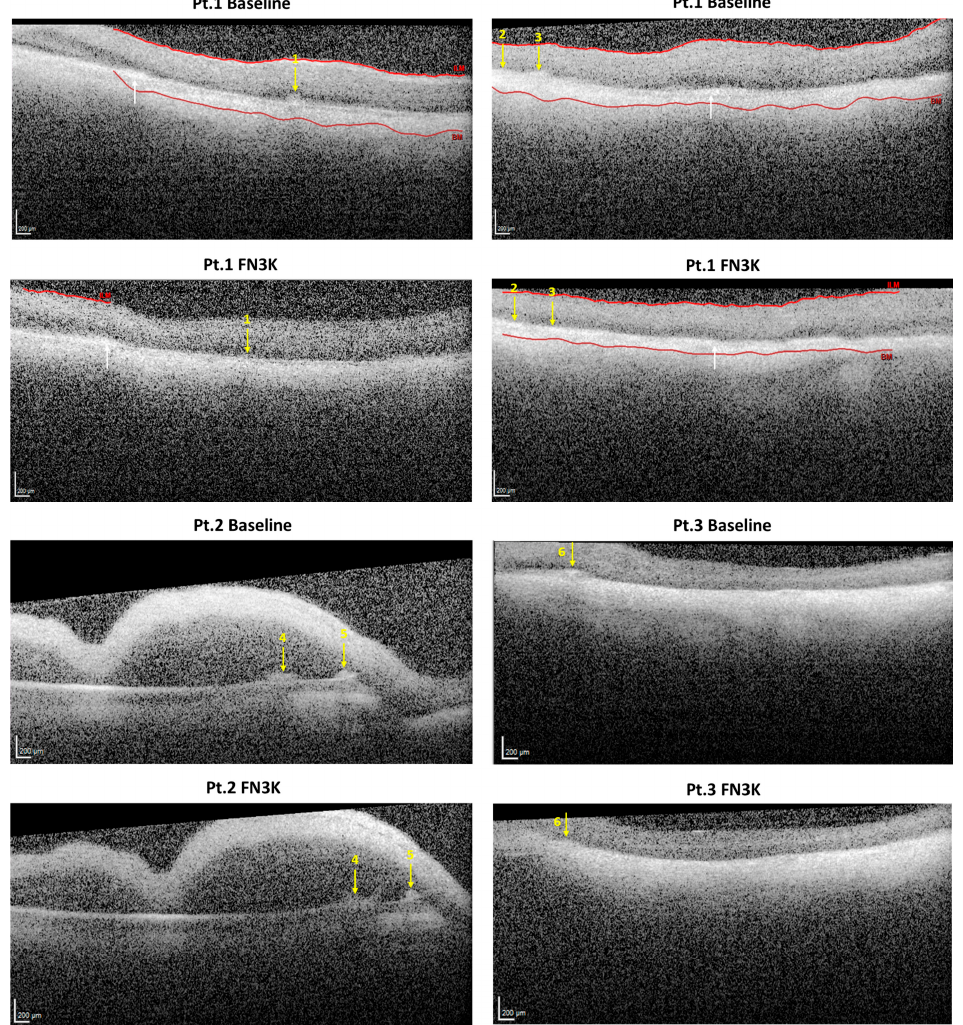
Figure 6. Optical coherence tomography (OCT) imaging of subretinal drusenoid lesions in post-mortem eyes of a 92-year-old patient with stage three AMD, i.e., right eye of Patient 1, a 74-year-old patient with stage 4 AMD (i.e., right eye of Patient 2) and a 79-year-old patient with stage 2 AMD (i.e., left eye of Patient 3) at baseline and 2 h after injection with a fructosamine-3-kinase (FN3K) solution. Subretinal drusenoid lesions ( n = 6) are indicated with numbered yellow arrows. White arrows show highly intense zones, presumably corresponding to atrophic scar tissue. If recognized by the automatic detection system, the Bruch’s membrane (BM) and inner limiting membrane (ILM) are delineated with red lines. The scale bars are 200 µm.